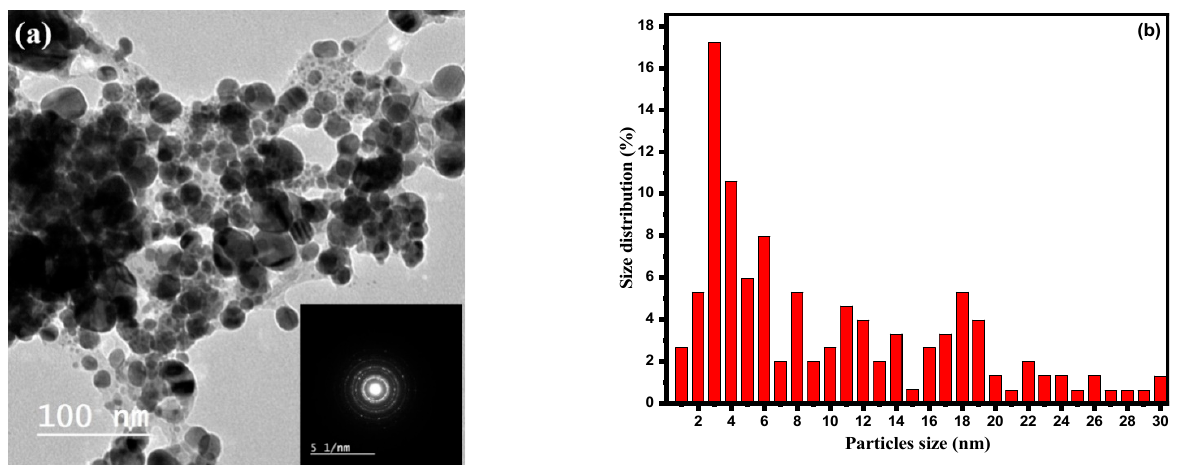
Figure 5. ( a ) TEM, ( b ) size distribution histogram of CA-AgNPs.